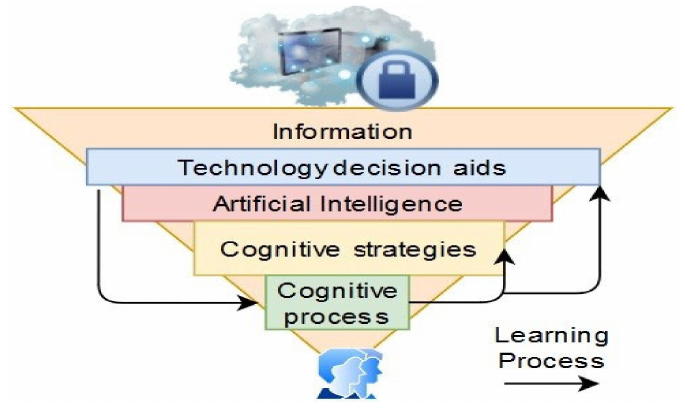
Figure 1. Relation between Information, Technology aids, and Cognitive